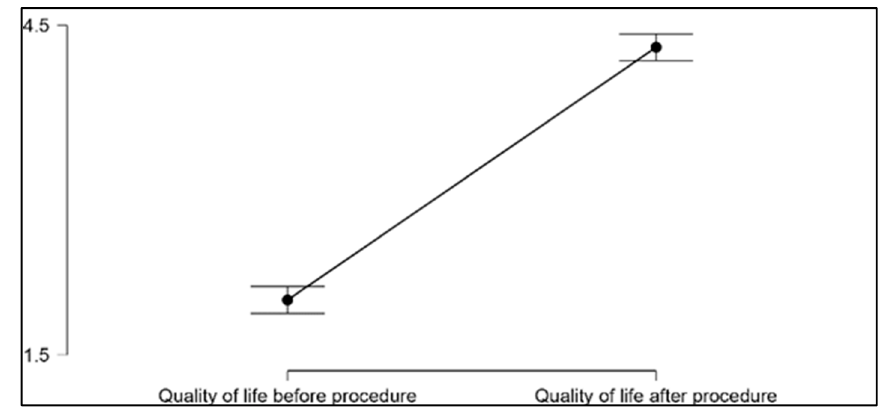
Figure 4. Quality of life: before/after the procedure.